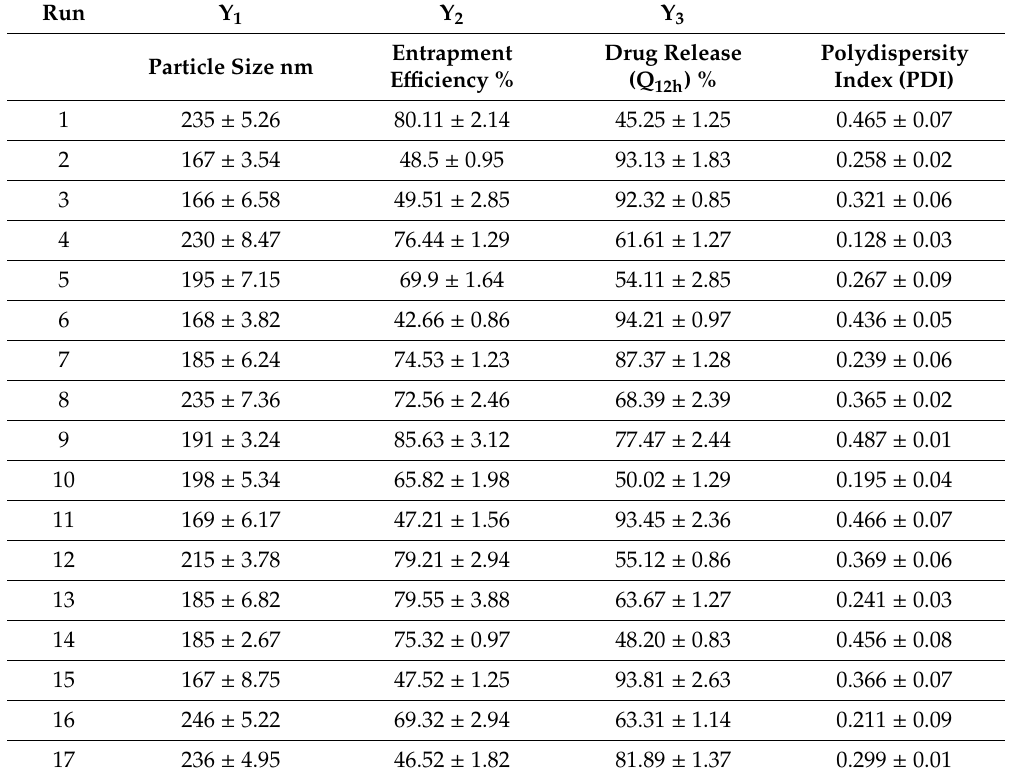
Table 3. The measured responses of prepared SGN–TC nanoparticles according to the Box-Behnken experimental